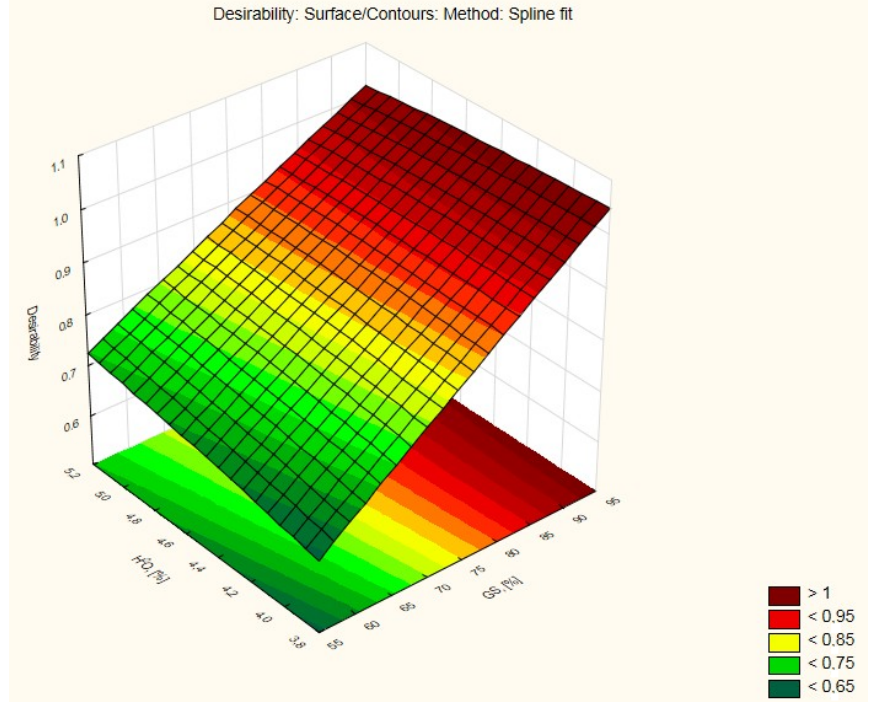
Figure 8. Compressive strength diagram for autoclaved brick modified with glass sand (GS) as a substitute for quartz sand (QS) in the presence of water (H 2 O).